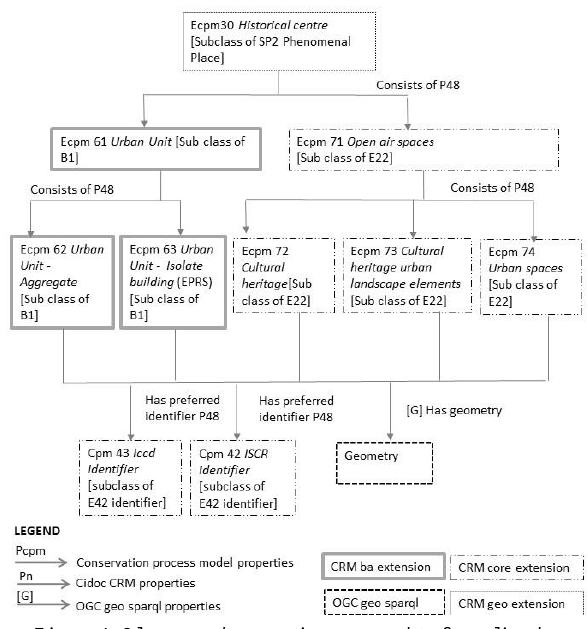
Figure 5. An algorithm works out the vulnerability index Figure 4. Classes and properties proposed to formalize the elaborating information retrieved from each urban urban structure.